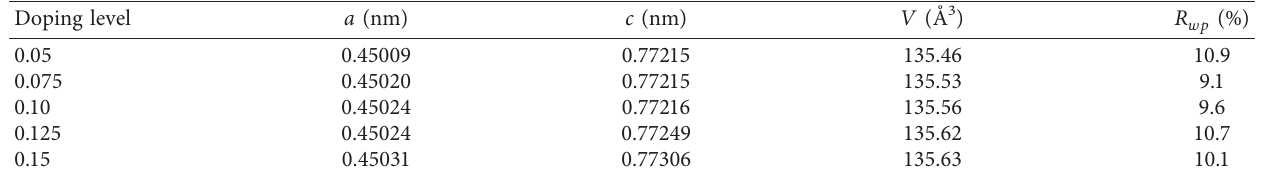
Mn x ) Sb . 1 − x 2 2